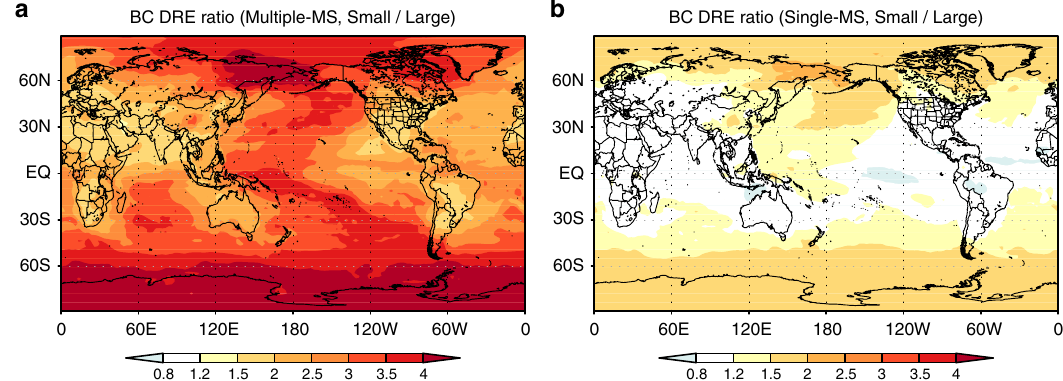
Fig. 2 Spatial distributions of the sensitivity of black carbon direct radiative effect. The ratio (dimensionless) of black carbon (BC) direct radiative effect (DRE) between the Small-size and Large-size simulations for the a Multiple-mixing-state and b Single-mixing-state representations